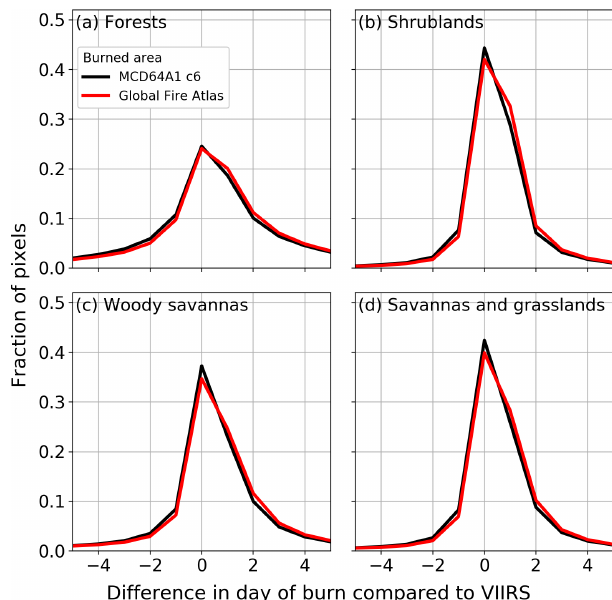
Figure 4. Global comparison of burn dates derived from the MCD64A1 burned-area product, the Global Fire Atlas and VI- IRS active-fire detections (2012–2016). (a) Forests, (b) shrublands, (c) woody savannas, and (d) savannas and grasslands. Negative val- ues indicate pixels with a burned-area day of burn earlier than the corresponding VIIRS active-fire detection, zero indicates no differ- ence in day of burn between both datasets, and positive numbers indicate a delayed detection of burned-area compared to active-fire